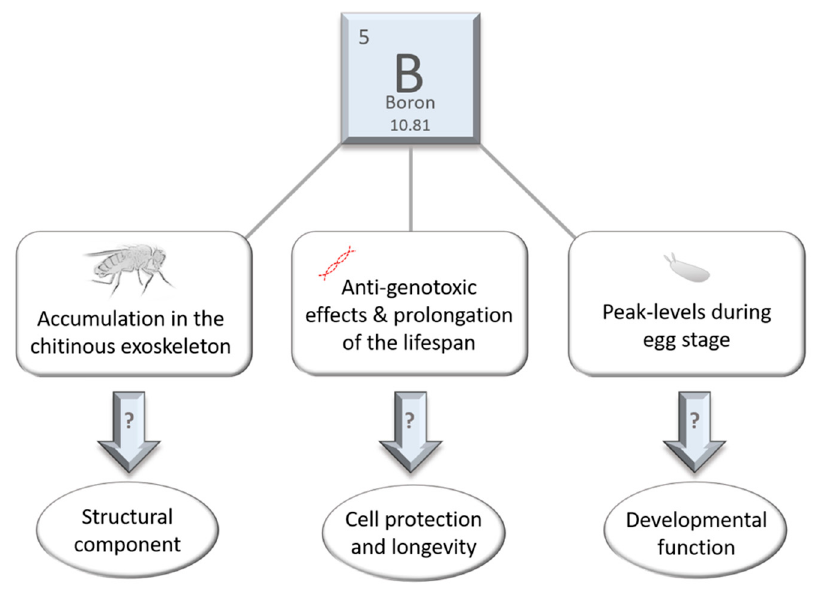
Figure 2. Boron-related bioactivity in D. melanogaster . Boron (atomic number: 5, relative atomic weight: 10.81) was found to accumulate in the chitinous exoskeleton of the adult fly indicating that B might be required for structure and stability. Anti-genotoxic effects and prolongation of the lifespan through B-application show that trace amounts of the element may be required for cell health and longevity. Peak levels of B at the egg stage indicate a potentially important function for embryonic development.